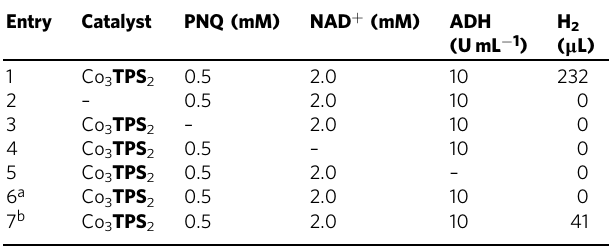
Table 1 Supramolecular semibiological system for light- driven alcohol